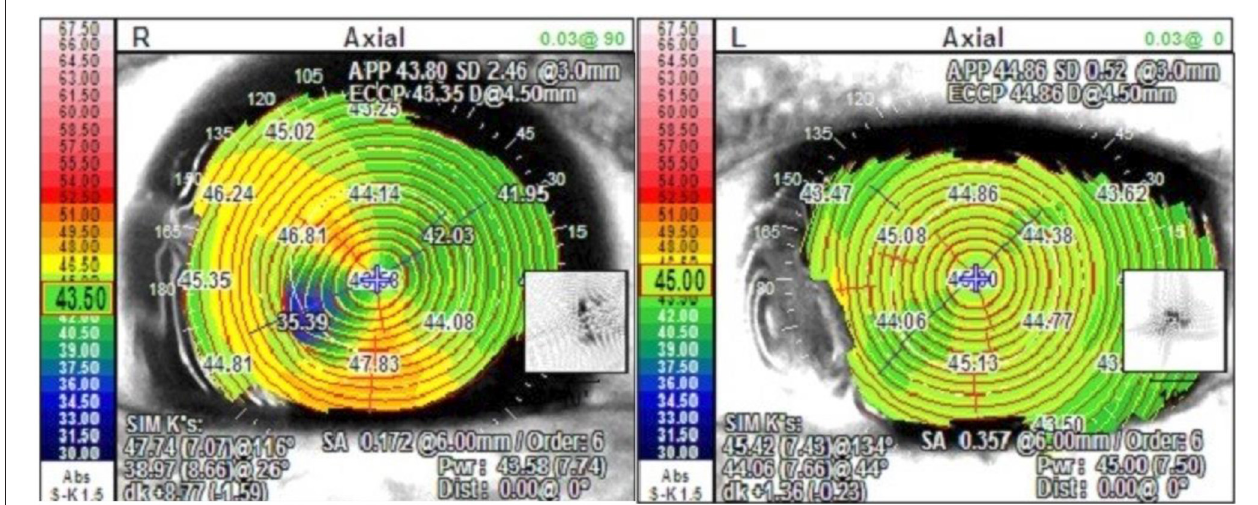
FIGURE 5 | Topographic map of Case 1 post operatively with tectonic corneal graft in the right eye and AM transplantation in the left eye.